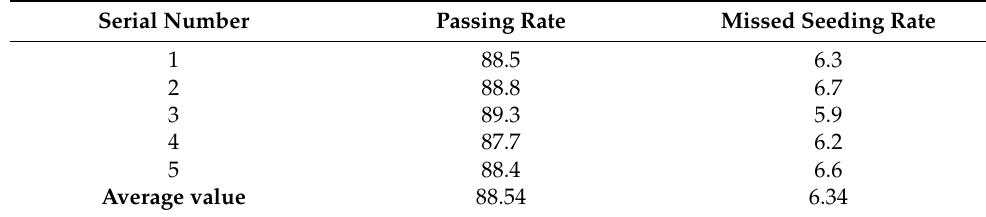
Table 7. Optimization of test results.